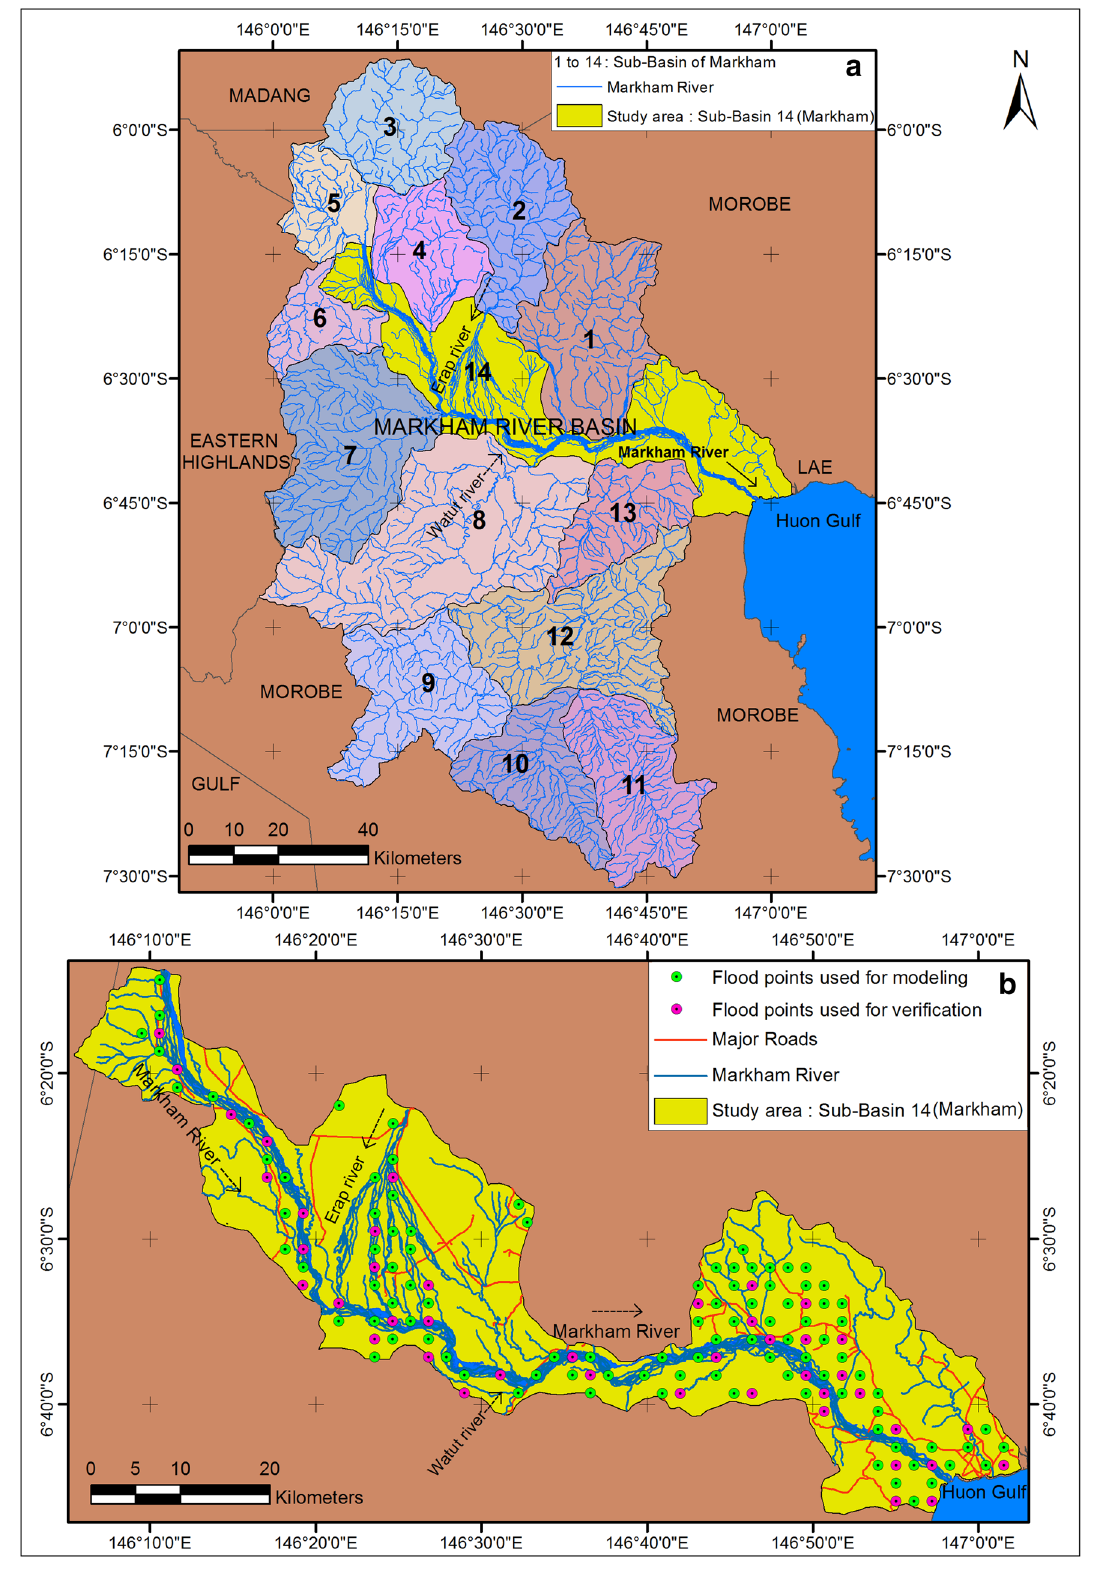
Fig. 1 Location map of the study area: ( a ) Entire Markham river basin and ( b ) The study area-sub-basin